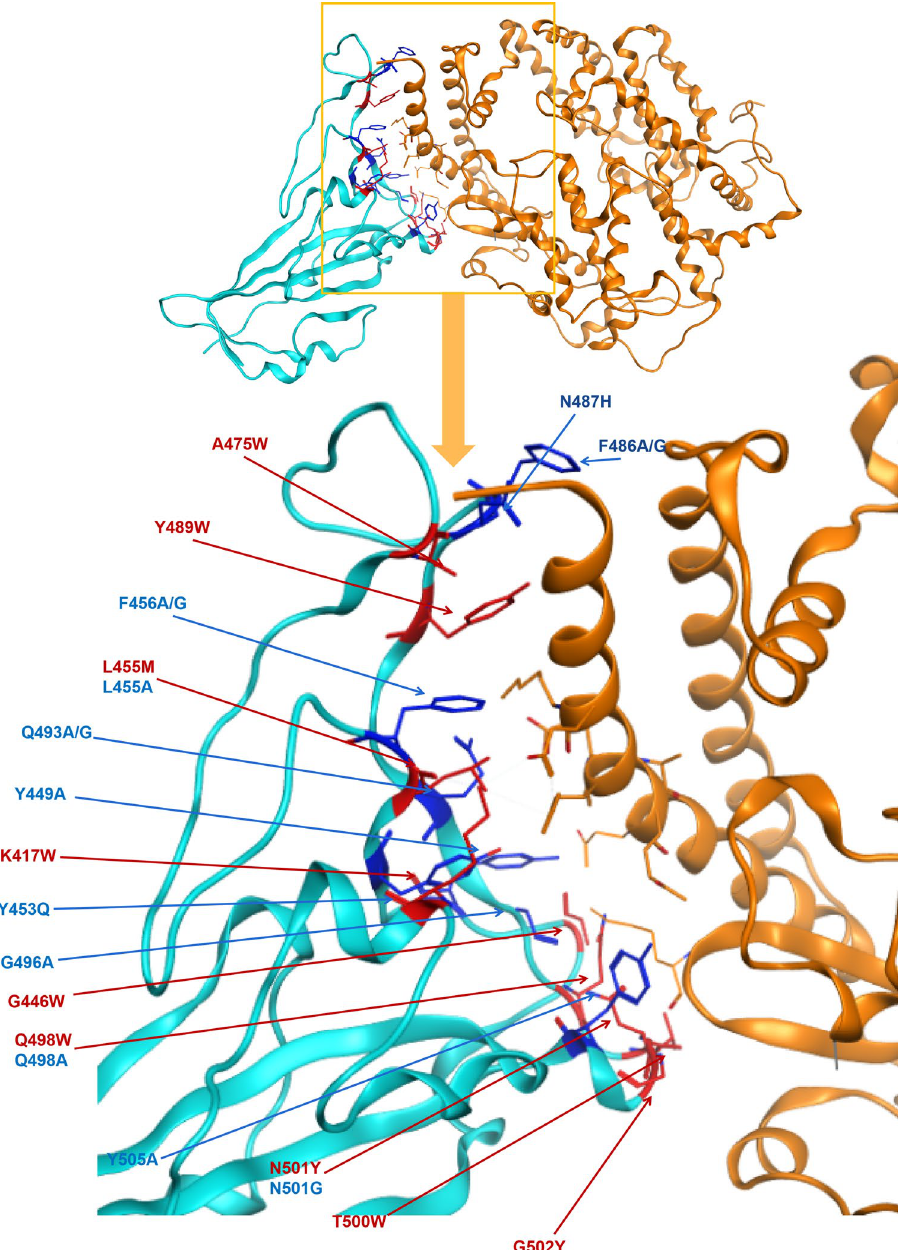
Figure 4. Identified variants in spike protein RBD mapped to the structure of spike protein in SARS-CoV-2 in complex with ACE2 in humans. Blue = spike protein, Orange = ACE2 direct binding to spike protein. Twenty- three point mutation causing affinity significant change on direct binding of spike protein of SARS-CoV-2, dark blue presents decreasing affinity while red shows